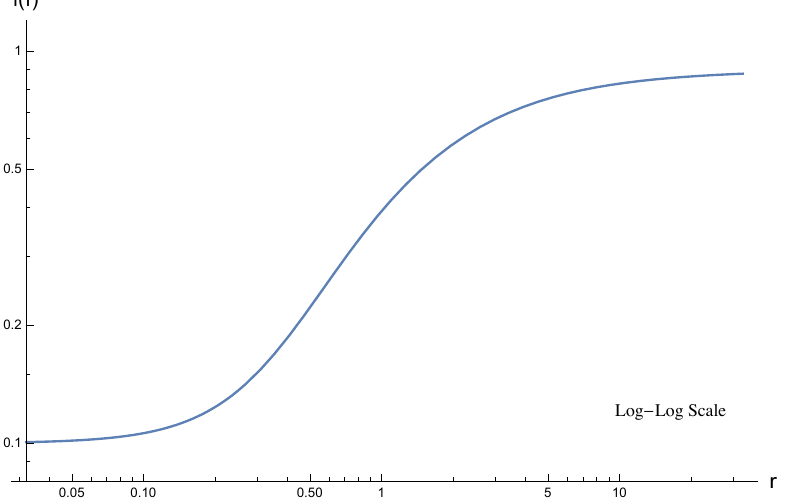
√ g tt = f ( r ) ; note that f ( 0 ) (cid:54) = 0, f ( ∞ ) =